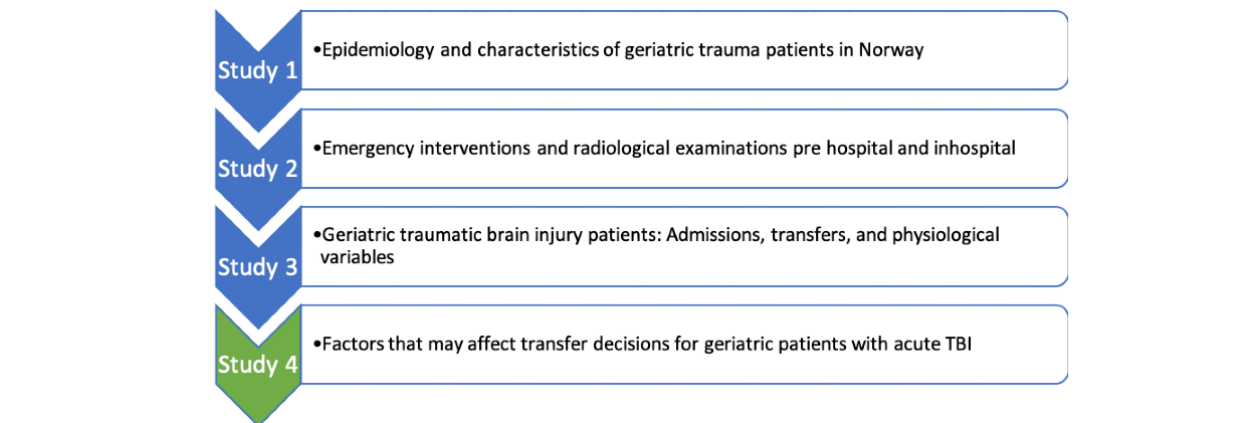
Figure 1. An overview of the four studies included in the project. TBI: traumatic brain